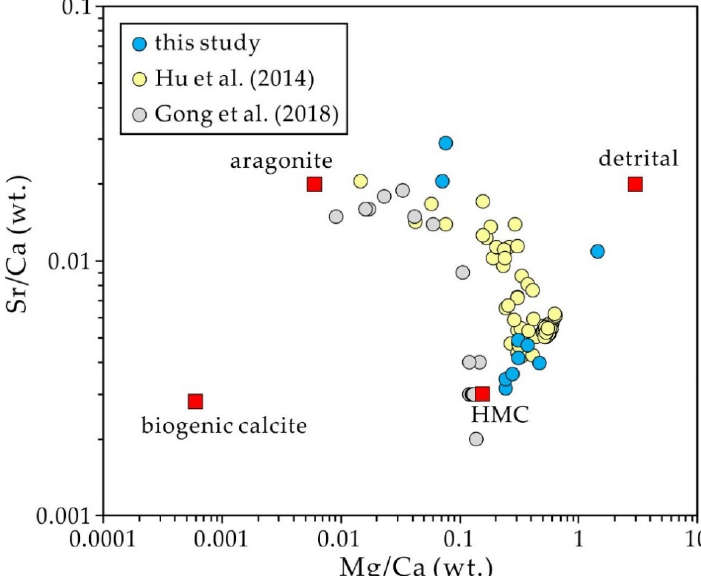
Figure 4. Relationship between Sr/Ca and Mg/Ca (wt. ratio) of carbonate samples. The end members of the Sr/Ca and Mg/Ca ratios were 0.020 and 0.0063 for aragonite and were 0.0031 and 0.155 for high magnesium calcite (HMC), respectively; data from Gong et al. [42]. The end-member ratios of the biogenic calcite and the detrital fraction are from Yang et al. [43]. Table 1. Selected elemental contents of carbonate phases and bulk